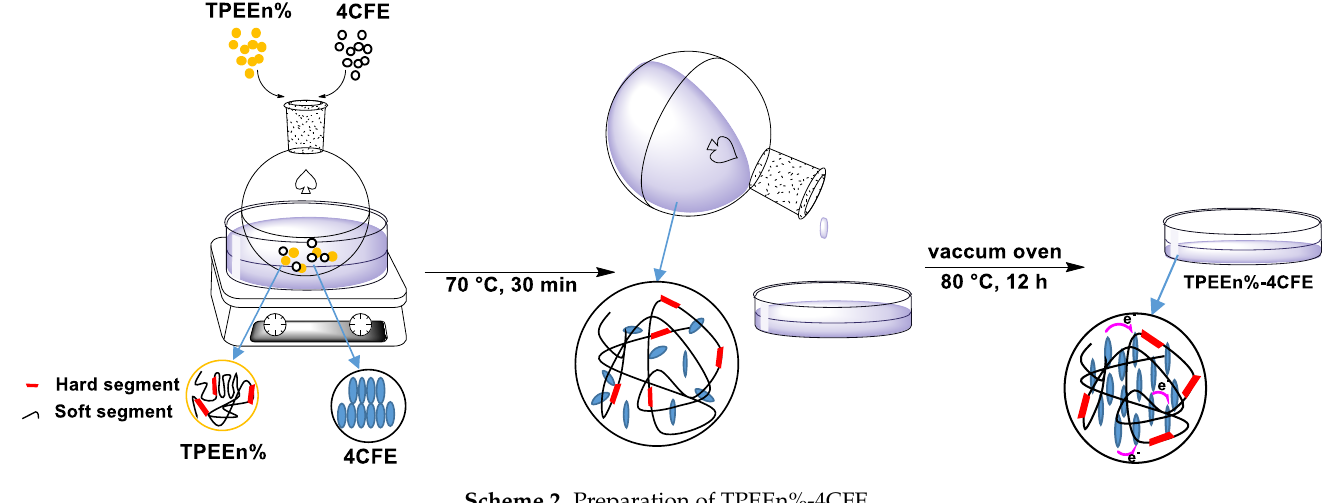
Scheme 2. Preparation of TPEEn%-4CFE.